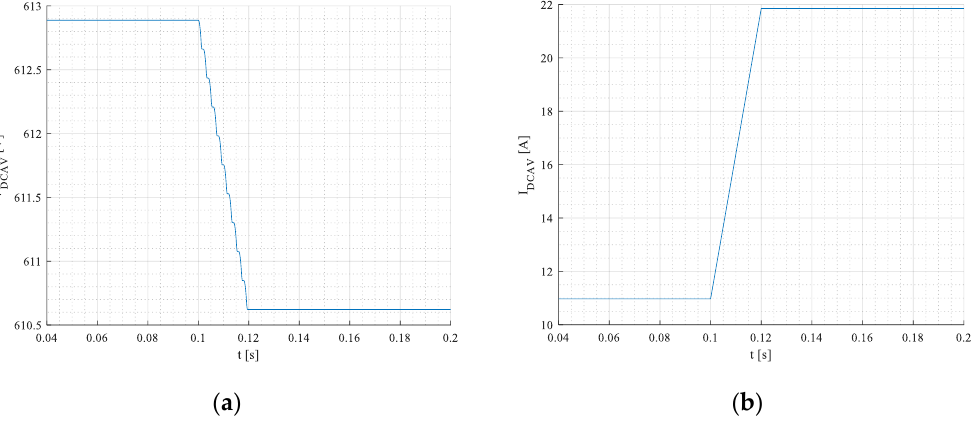
Figure 17. Voltage ( a ) and current ( b ) in the DC side under step change of resistive load. Apparent, active, blind, and distortion powers during transient states are shown in Figure 20a – d.